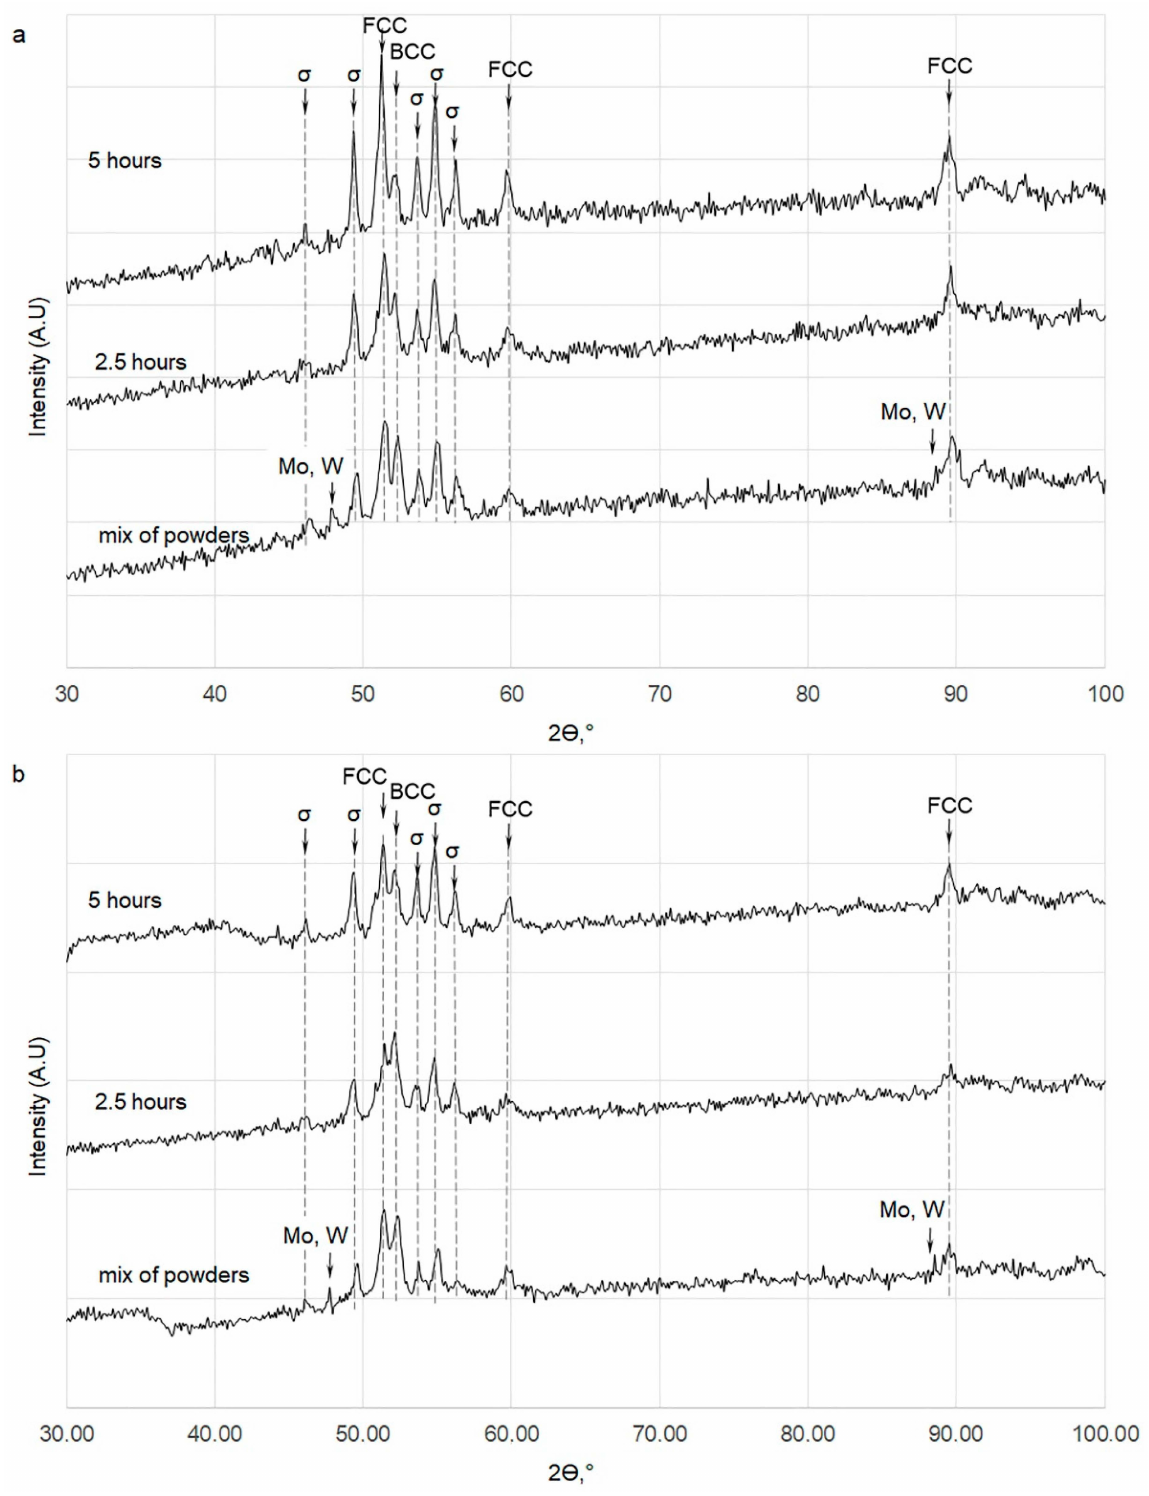
Figure 7. XRD patterns of the bulks produced during pressure-assisted sintering process: ( a )—35Fe30Cr20Ni10Mo5W; ( b